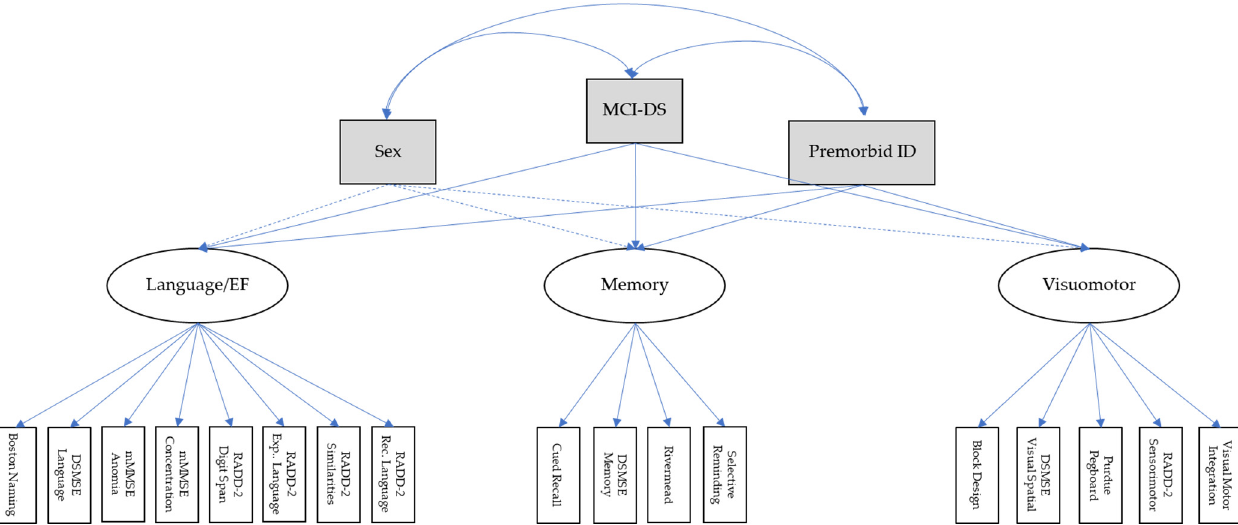
Figure 1. Structural equation model of how MCI-DS affected performance on the 17 cognitive measures and 3 latent variables. Solid lines indicate paths that were statistically significant, p s = 0.001. Ovals represent the endogenous variables with their indicator variables represented by white rectangles. CFI = Comparative Fit Index, CI = confidence interval, DSMSE = Down Syndrome Mental Status Examination, EF = executive function, Exp = expressive, ID = intellectual disability, mMMSE = Modified Mini-Mental Status Exam, MCI-DS = Mild Cognitive Impairment-Down syndrome, RADD-2 = Rapid Assessment of Developmental Disabilities-2nd Edition, Rec = receptive, RMSEA = root mean square error of approximation, Model Fit Indices: Chi-square = 299.20, CFI = 0.91, RMSEA = 0.08, 90% CI =